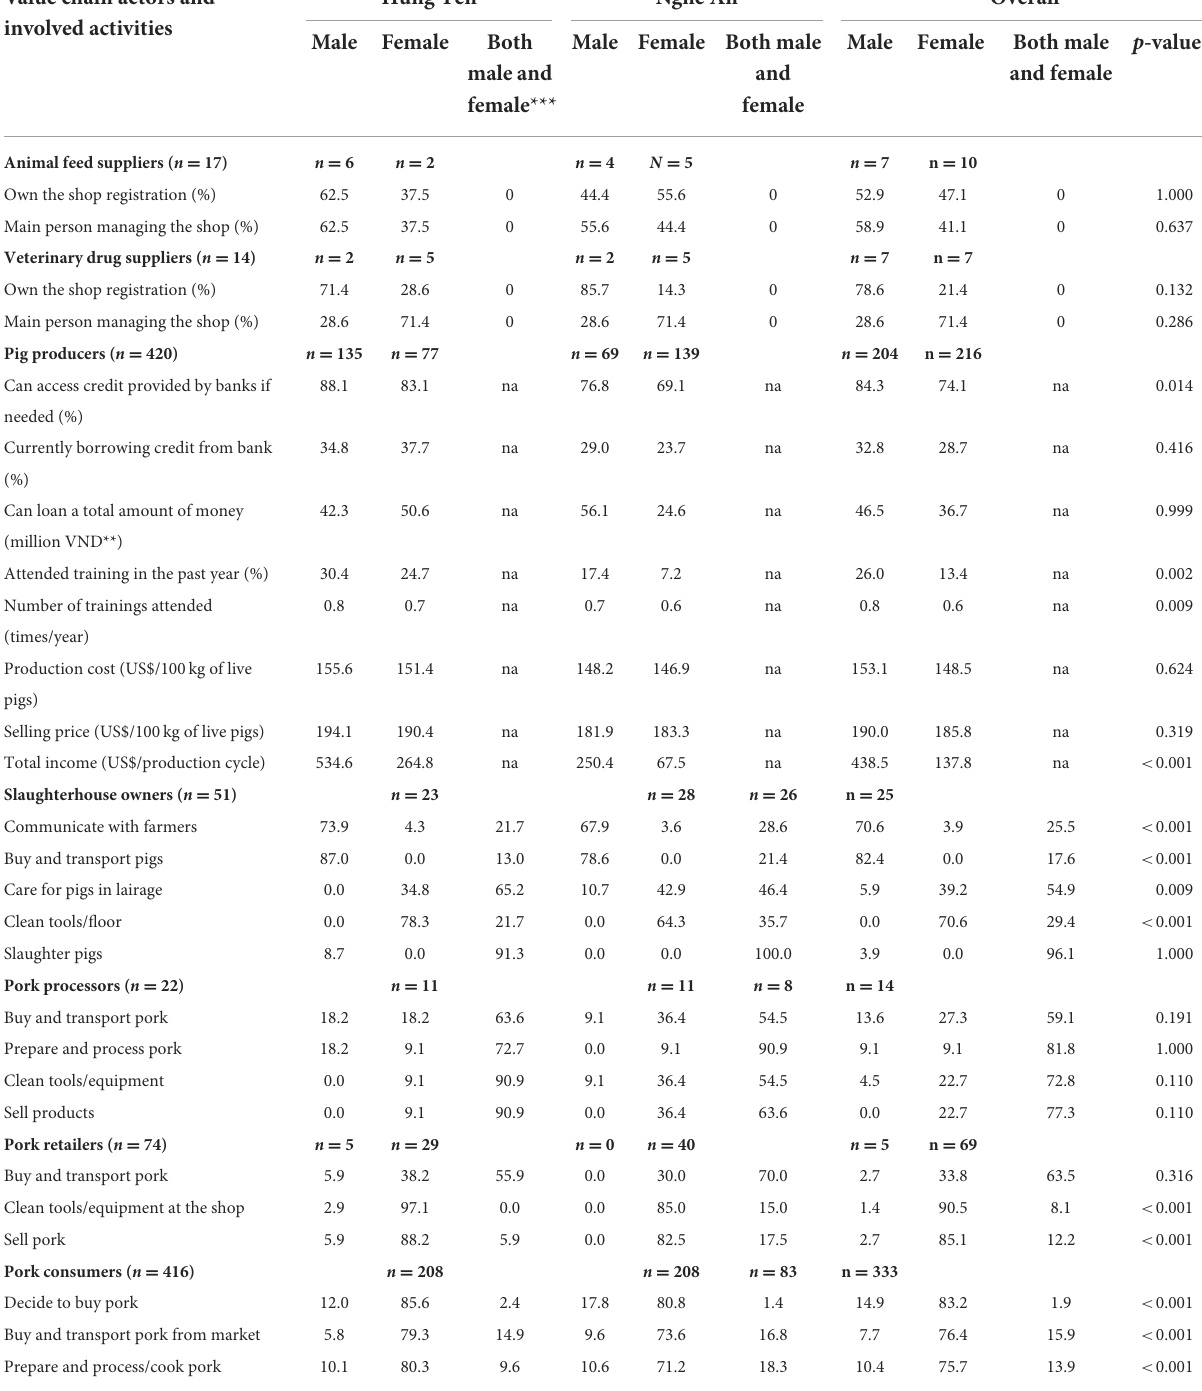
TABLE 2 Gendered participation levels in different activities by provinces and actors along pig value chains. Value chain actors